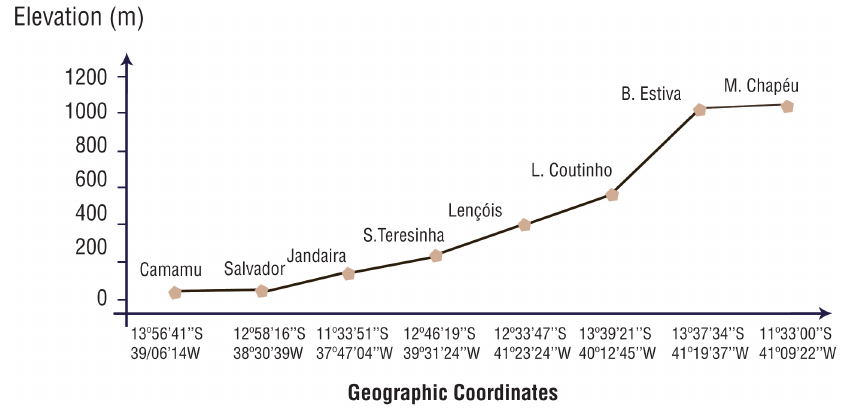
Fig. 1 - Areas of natural occurrence of Melipona scutellaris in the state of Bahia, Brazil. SPRING software v. 4.1 (Camara et al.